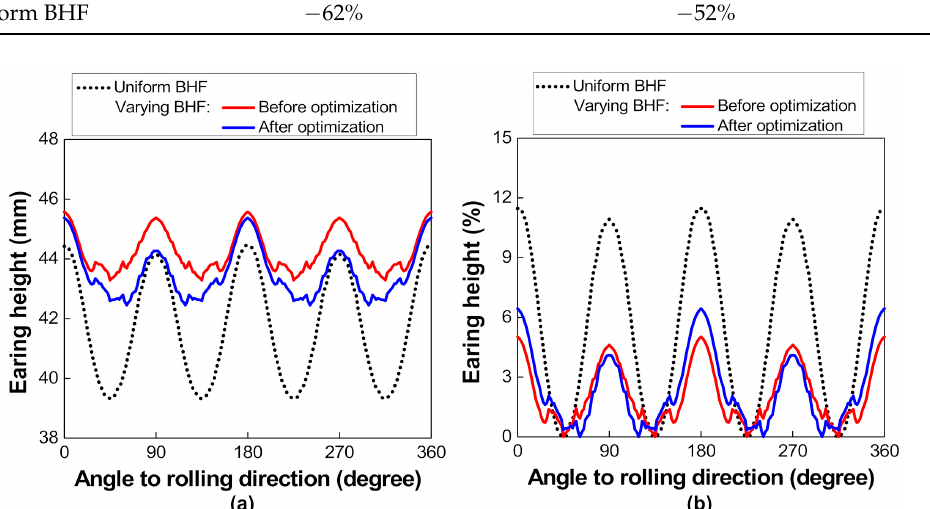
Figure 14. Results of ( a ) earing height and ( b ) % earing height profiles of AA1050-O predicted with varying BHFs before optimization and after optimization using the integrated DNN-GA model. Table 3. Varying blank holding force (N) before and after optimization compared to the analytical model resulting in the reduction in earing height variation.